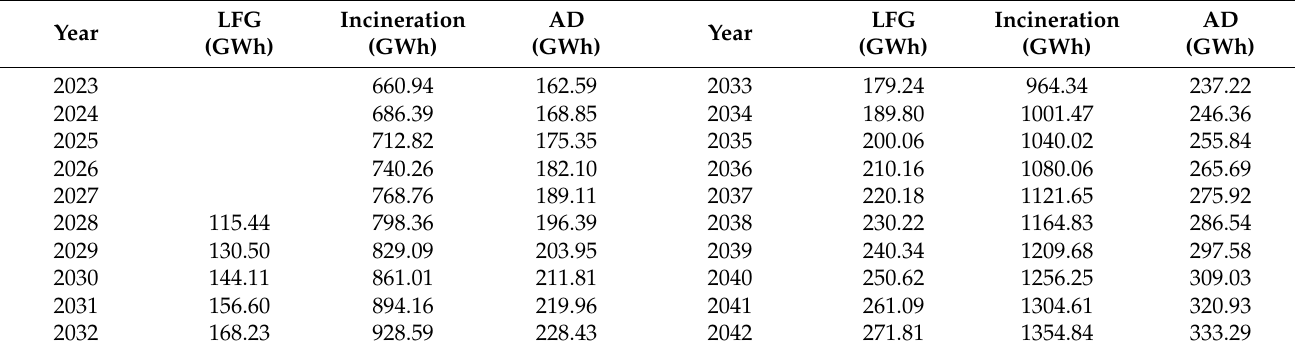
Table 5. ERP over the lifetime of WTE technologies.